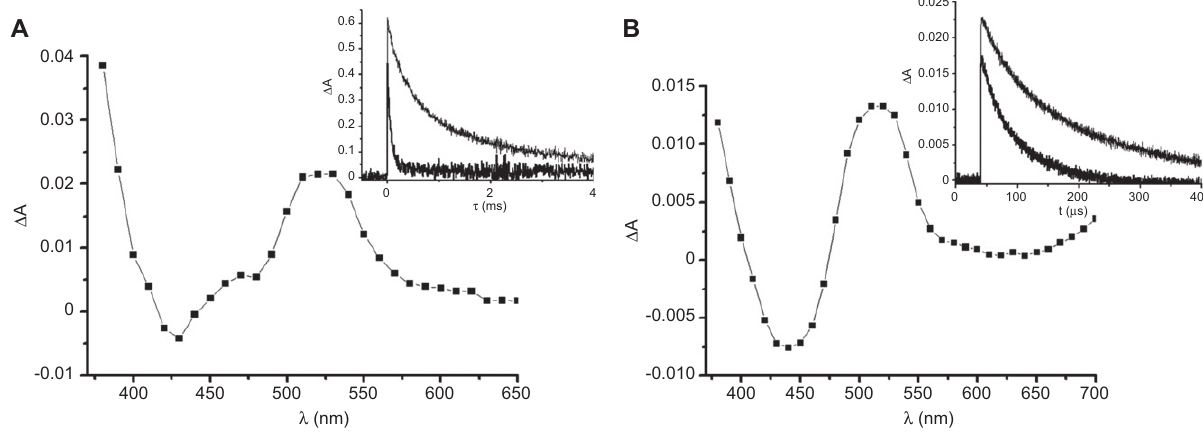
Figure 2 Transient spectrum of: (A) a 1b solution (5 × 10 -5 ) in DMF in the presence of 0.01 m sodium ascorbate. Inset: profile of the absorb- ance change at 510 nm (upper curve, measured τ = 960 μ s) and in the presence (lower curve) of Ni(cyclam) (2) 5 × 10 -3 m ( τ = 92 μ s). (B) An analogous experiment with 1d ( τ = 93 μ s upper curve and τ = 80 μ s in the presence of 2 , lower